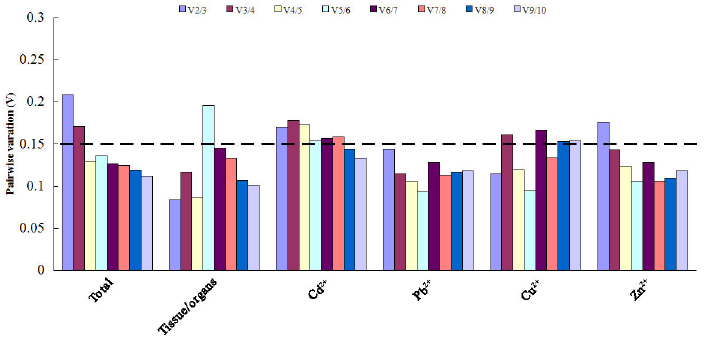
Figure 4. Pairwise variation (V) calculated by geNorm to determine the optimal number of reference genes. The average pairwise variations (Vn/Vn+1) were analyzed to measure the effect of adding additional reference gene on the RT-qPCR normalization for all samples.